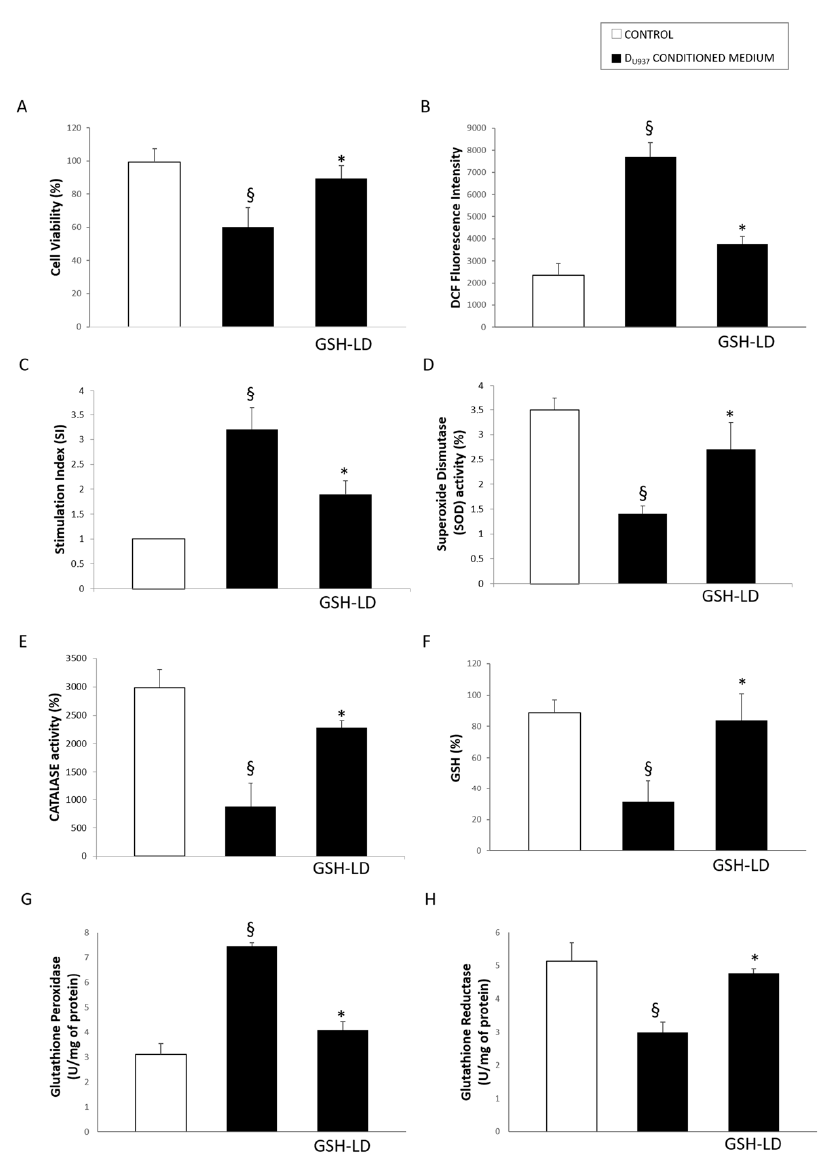
Figure 7. Effect of GSH-LD on D SH-Sy5Y cells treated with conditioned medium obtained from activated D U937 cells. D SH-Sy5Y cells pre-treated with GSH-LD (1 µ M, 1 h) and exposed to conditioned medium obtained from activated D U937 cells. After 24 h were conducted: ( A ) MTT assay; ( B ) Reactive oxygen species (ROS) production measured by DCF (2 ′ ,7 ′ -dichlorofluorescin diacetate) fluorescence; ( C ) Measurement of ROS levels using NBT (Nitroblue tetrazolium) assay expressed as stimulation index; ( D ) Superoxide Dismutase (SOD) activity ( E ) Catalase (CAT) activity; ( F ) GSH level; ( G ) Glutathione Peroxidase (GPx) and H) Glutathione Reductase (GR) assay. Values are mean ± SD, n = 5; § p < 0.05 vs CTRL; * p < 0.05 vs cells treated with conditioned medium.